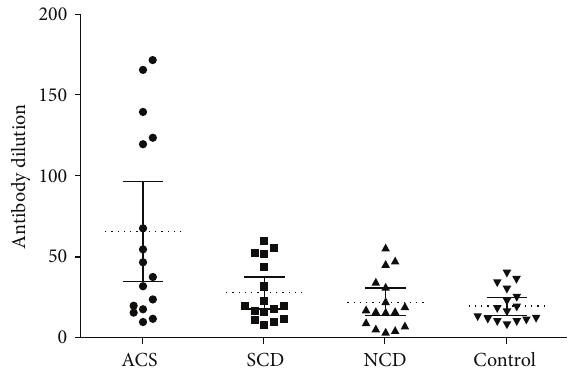
Figure 1: The titers of AT1-AAs in the sera sample collected from each group of patients with CHD measured by repeated ELISA. Titers of AT1-AAs in different group of patients and the healthy control group were all shown in the figure. The positive patient was defined as the titer higher than 1 :40. AT1-AAs in ACS group were significantly different from the SCD, NCD, and control groups ( 𝑃 < 0.001 ) and the positive rate was 50%, 31%, 19%, and 6%. The AT1-AAs used for the following experiments were collected from the 5 positive sera samples of ACS group separately, with the antibody titer higher than 1: